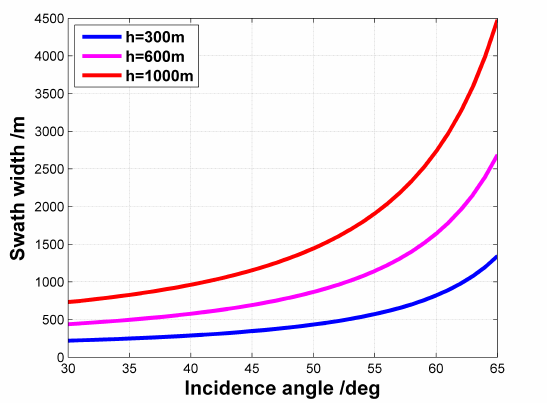
Figure 3. Swath widths of UAV SAR at different flight